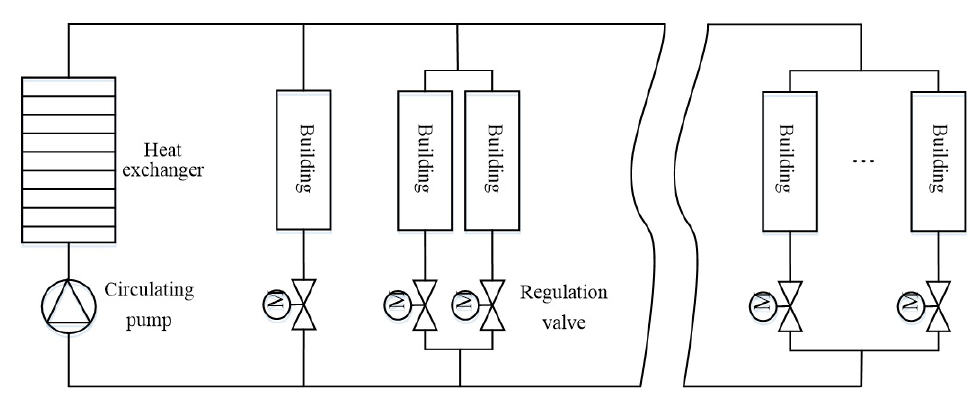
Fig. 1 Diagram of heating system